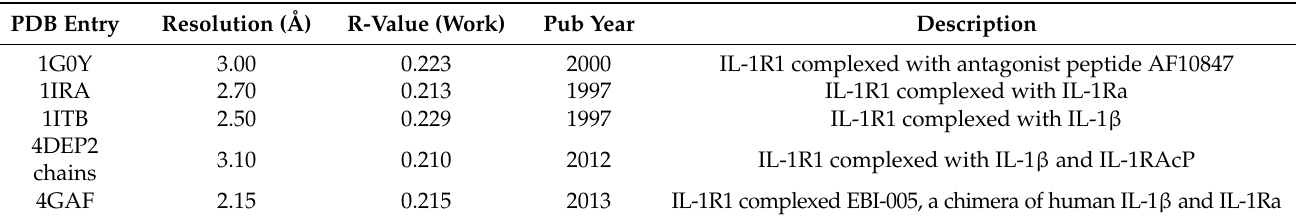
Table abbreviations: Interleukin receptor type-1 (IL-1R1); interleukin-1 β (IL-1 β ); interleukin-1 receptor antagonist (IL-1Ra); interleukin-1 receptor accessory protein